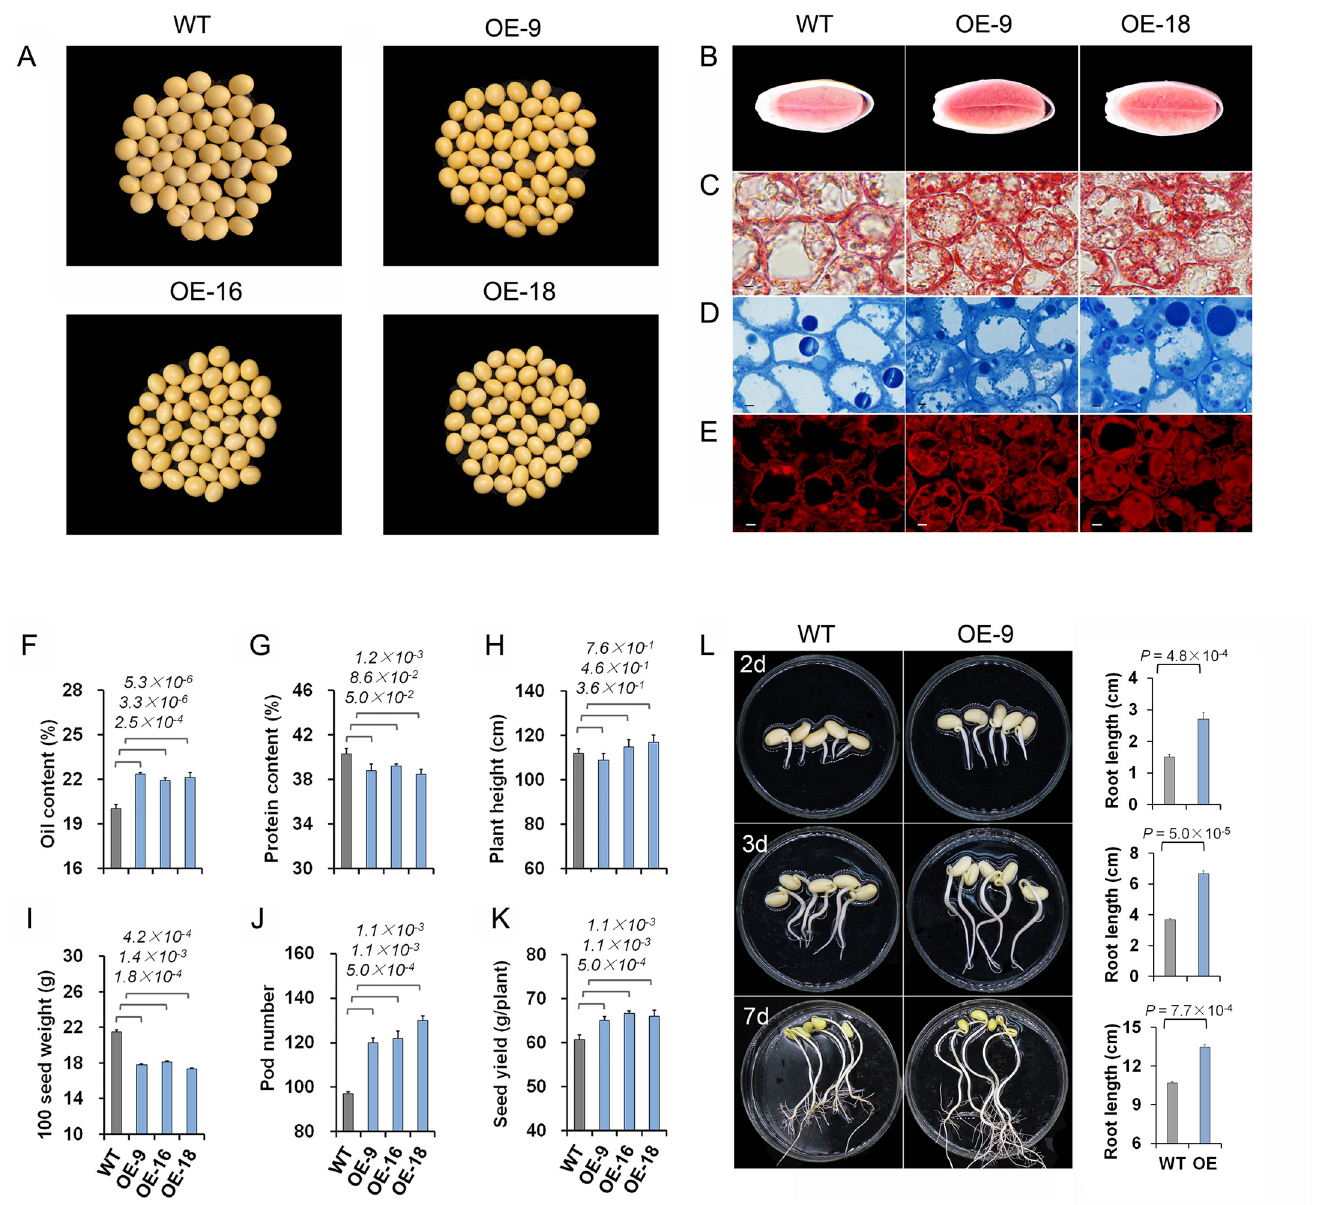
Fig 4. Characterization of transgenic soybeans overexpressing GmOLEO1 . A, Seed appearance comparison between WT and OE-9, OE-16, OE-18. T 3 seeds showed a shinier seed surface and smaller seed size than WT. B-E, Microscope-based visualization of lipid and OB accumulation in soybean seeds. B, Cross sections of soybean seeds at 25 DAF showing lipid accumulation as stained with Oil Red O. Two transgenic soybean seeds, OE-9 and OE-18, showed a higher level of TAG accumulation than WT seeds. C and D, Comparison of the abundance of oil bodies (OBs) stained with Oil Red O (C) and alkaline toluidine blue O (D) between the OE lines and WT as visualized using an optical microscope. E, Comparison of the abundance of OBs stained with Nile Red between the OE lines and WT as visualized with a confocal microscope, Bar = 10 μ m. F-K, Comparison of seed traits (F and G) and yield-related phenotypes between the OE and WT seeds, including plant height (H), 100-seed weight (I), pod number (J) and seed yield (K) per plant. L, Comparison of seed germination rate and root length between WT and OE-9 at 2, 3 and 7 days postgermination. OE-9 seeds showed faster seed germination than WT seeds. Error bars indicate SD (n = 5). Statistical significance was determined by